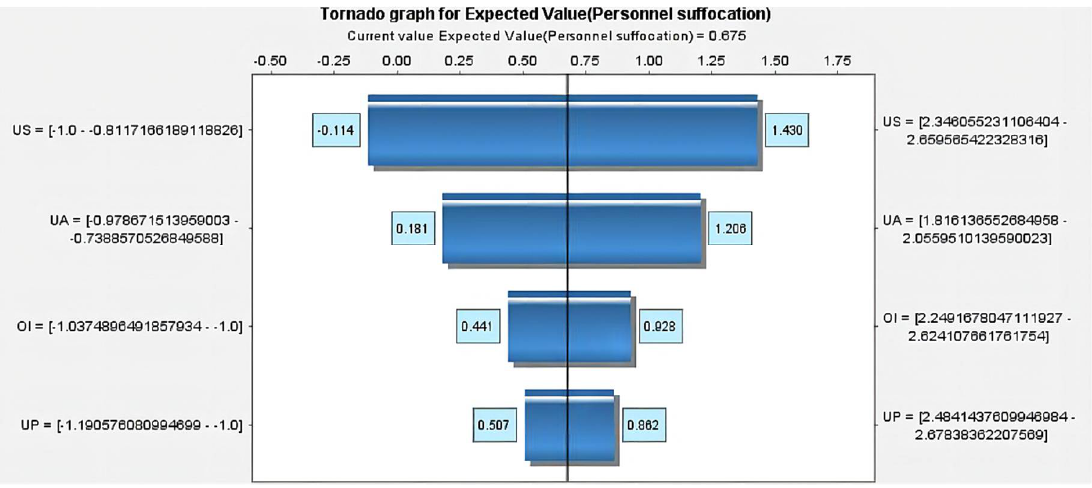
Figure 8. Sensitivity analysis of the intermediate nodes.